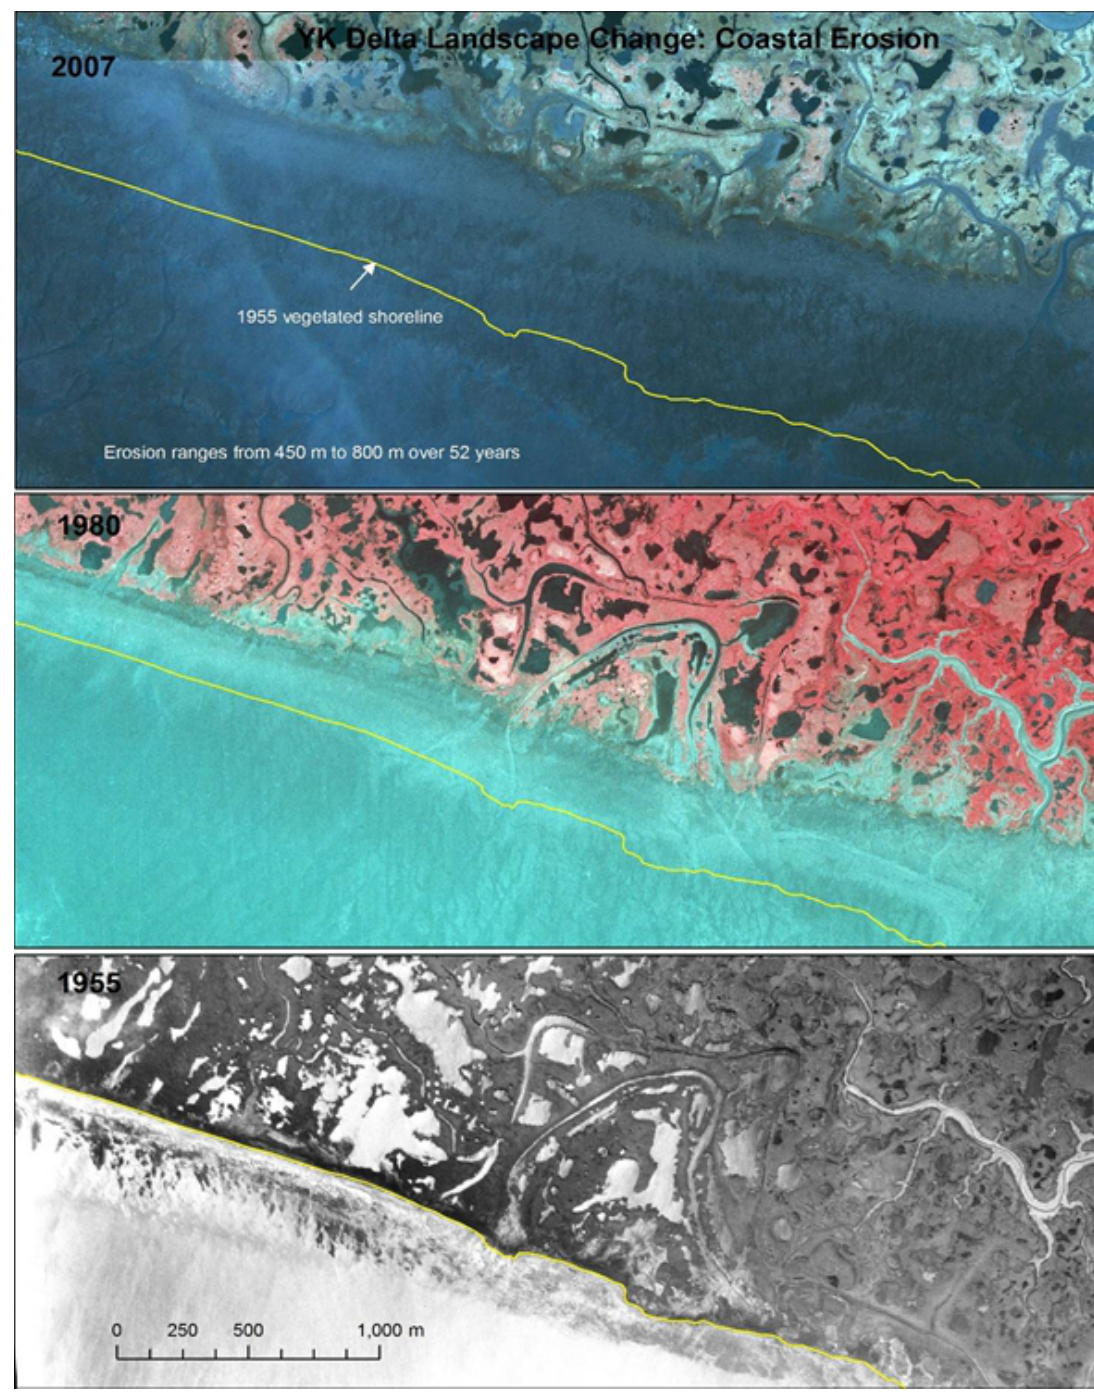
Figure 8. Example of coastal erosion evident on imagery from 1955, 1980 and 2007 along the central outer coast of the Yukon-Kuskokwim Delta. Coastal erosion was not detected within the sampling grids but there were obvious “hotspots” of erosion evident outside of the